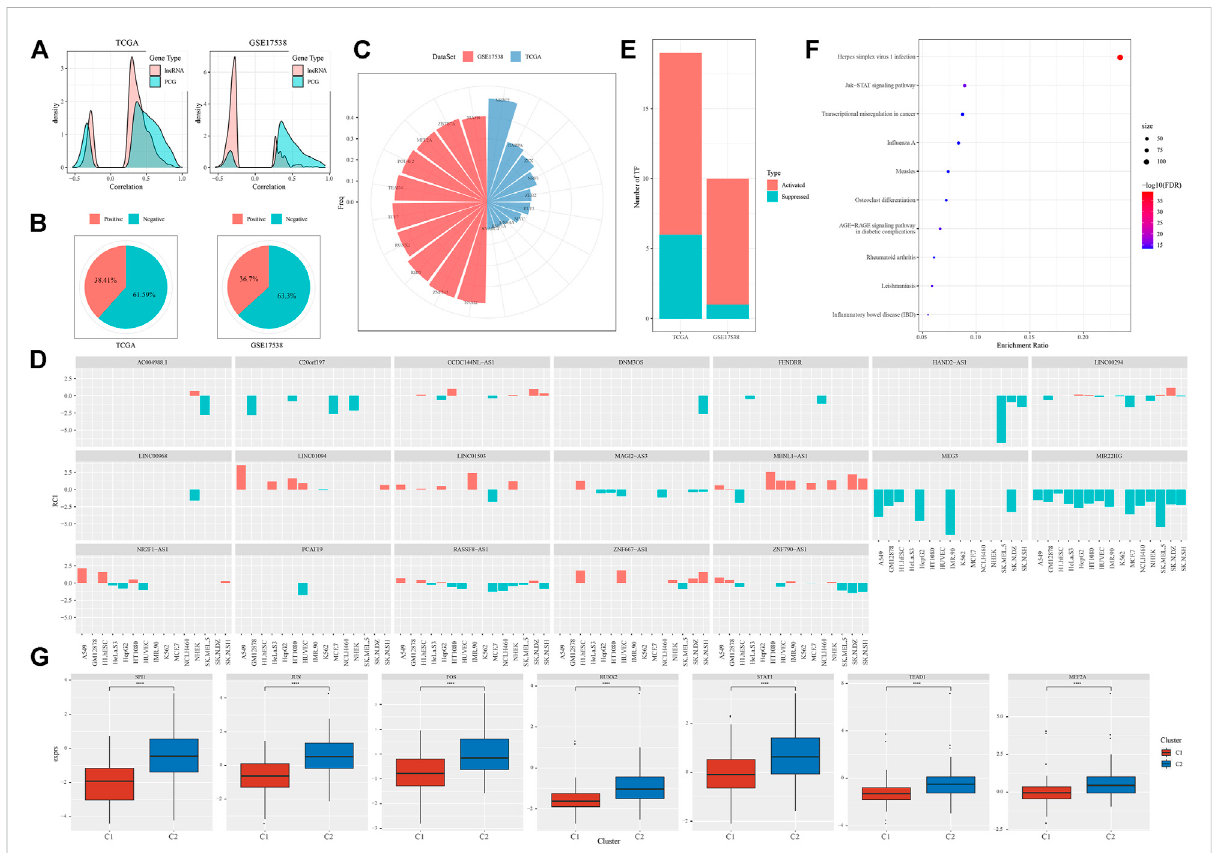
FIGURE 7 The relation between EMT-related lncRNAs and TFs (A) Pearson correlation analysis between EMT-related lncRNAs and PCGs in two cohorts. (B) Proportion of nuclear (negative) and cytoplasmic (positive) lncRNAs in two cohorts (C) The top 10 differentially expressed TFs associated with EMT-related lncRNAsof twocohorts. (D) 19of58 identi fi edEMT-related lncRNA with close relations to differentially expressed TFs (E) Activated and suppressed TFs by comparing C2 with C1. (F) GSEA of genes targeted by 7 upregulated TFs. Size indicates gene counts. (G) Comparison of expression of 7 upregulated TFs between C1 and C2 subtypes in TCGA-COAD cohort. Student t test was conducted. **** p <